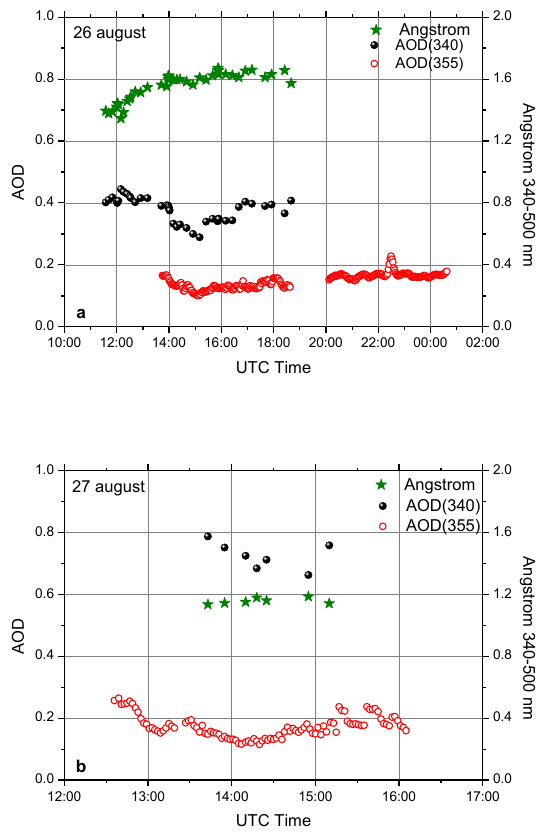
Figure 10. Aerosol optical depth at 340nm and Ångström param- eter at 340–500nm provided by AERONET on (a) 26 and (b) 27 August 2013. Open symbols show optical depth of the smoke layer at 355nm derived from Raman lidar measurements in the 2000– 5000m height range.